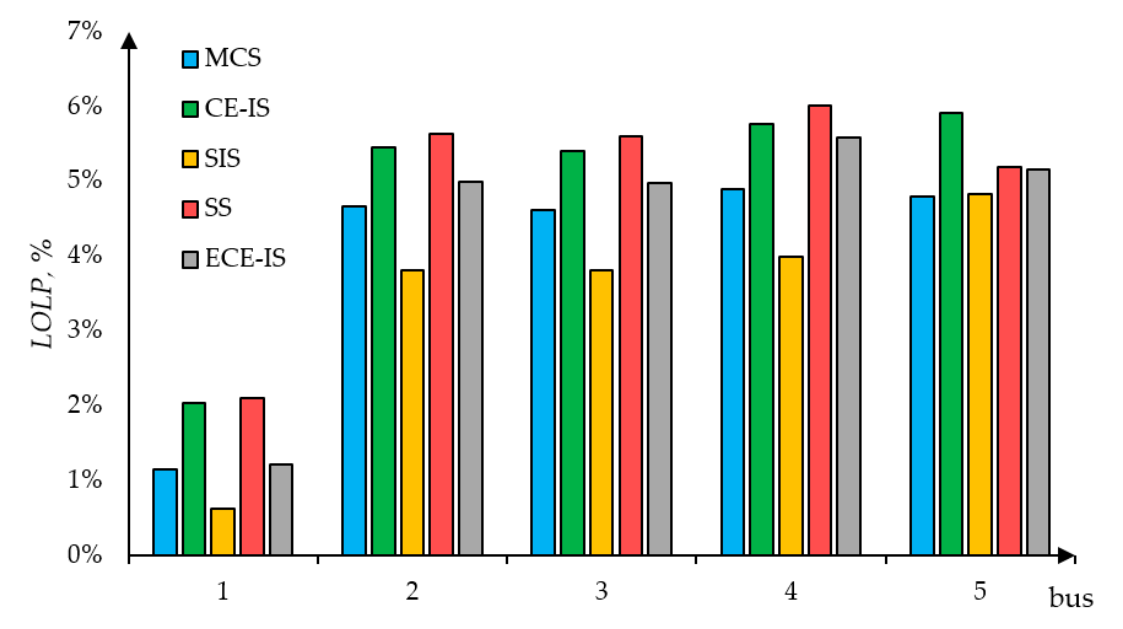
Figure 7. Test scheme buses—loss of load probability (LOLP).